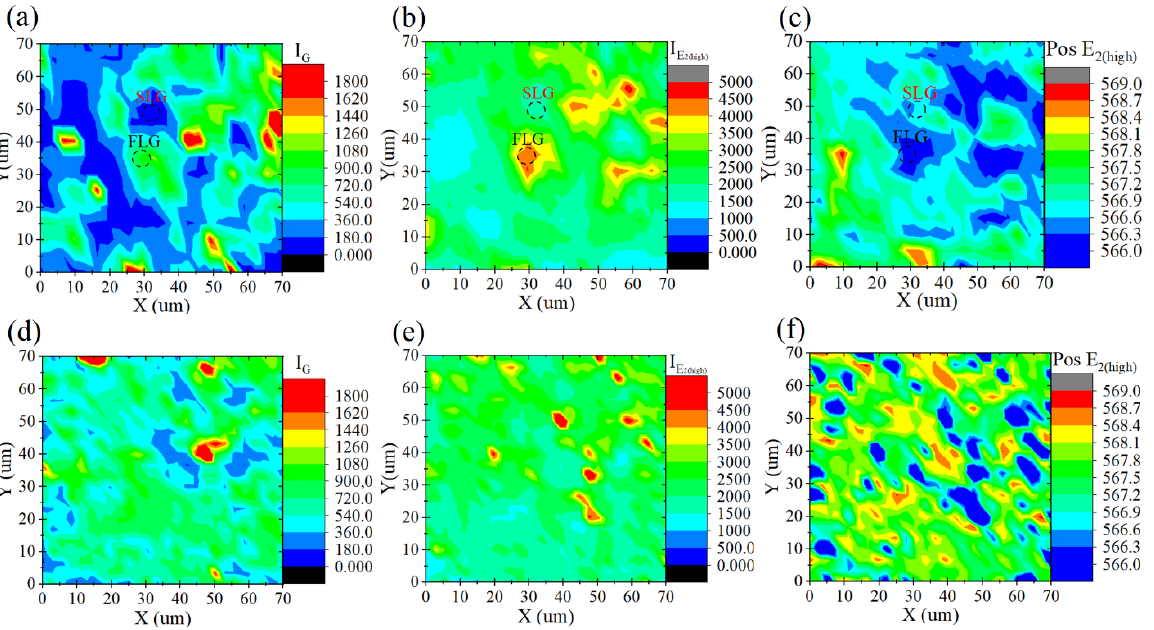
Figure 7. Raman analysis: ( a , d ) Raman mapping of G peak intensity and of the E 2(high) peak intensity ( b , e ) and position ( c , f ) from random areas on the continuous FLG ( a – c ) and MLG ( d – f ) after nitrides PA-MBE growth acquired at a laser excitation wavelength of 532 nm.